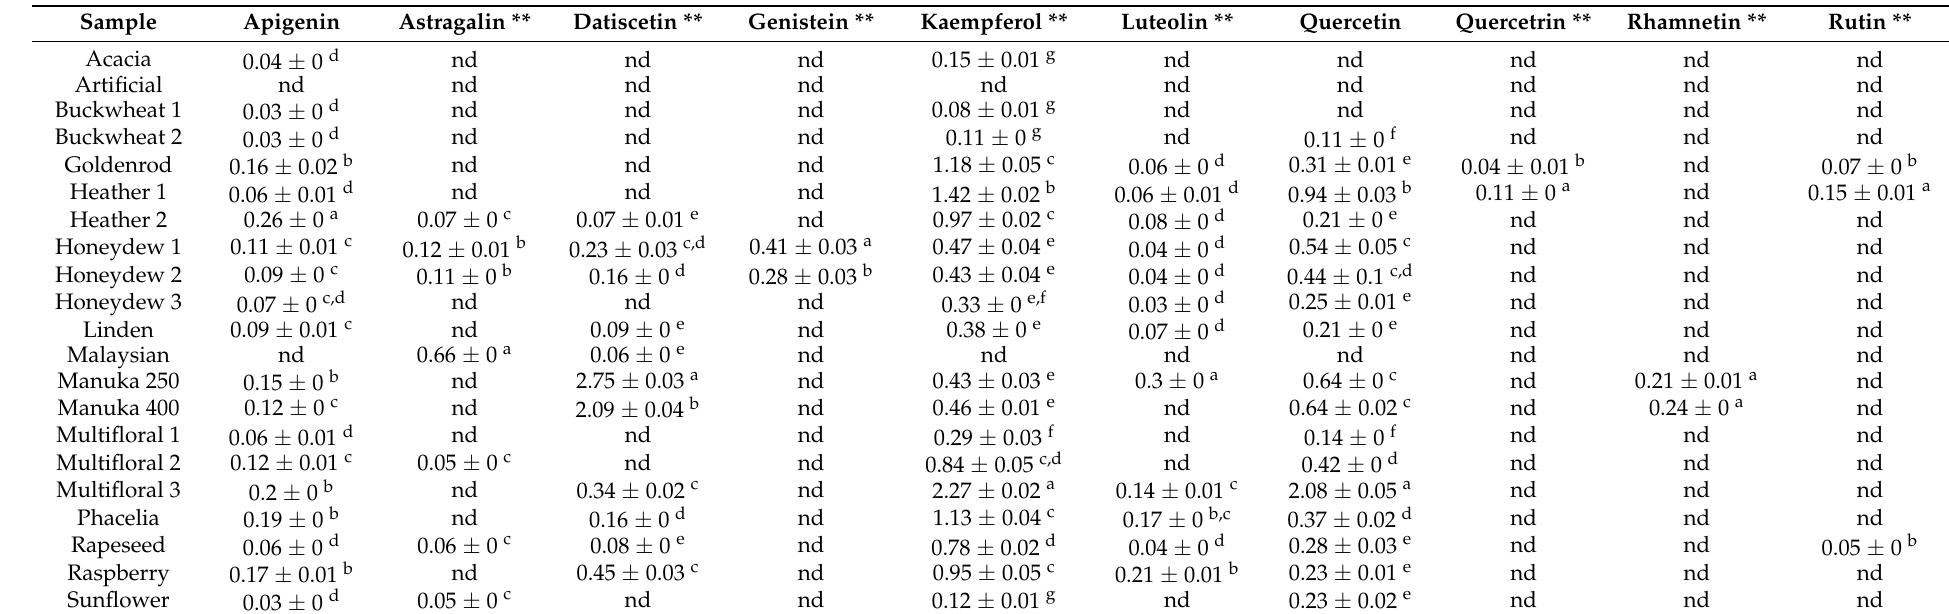
Table 3. Phenolic compounds of honeys—flavonoids [mg kg − 1